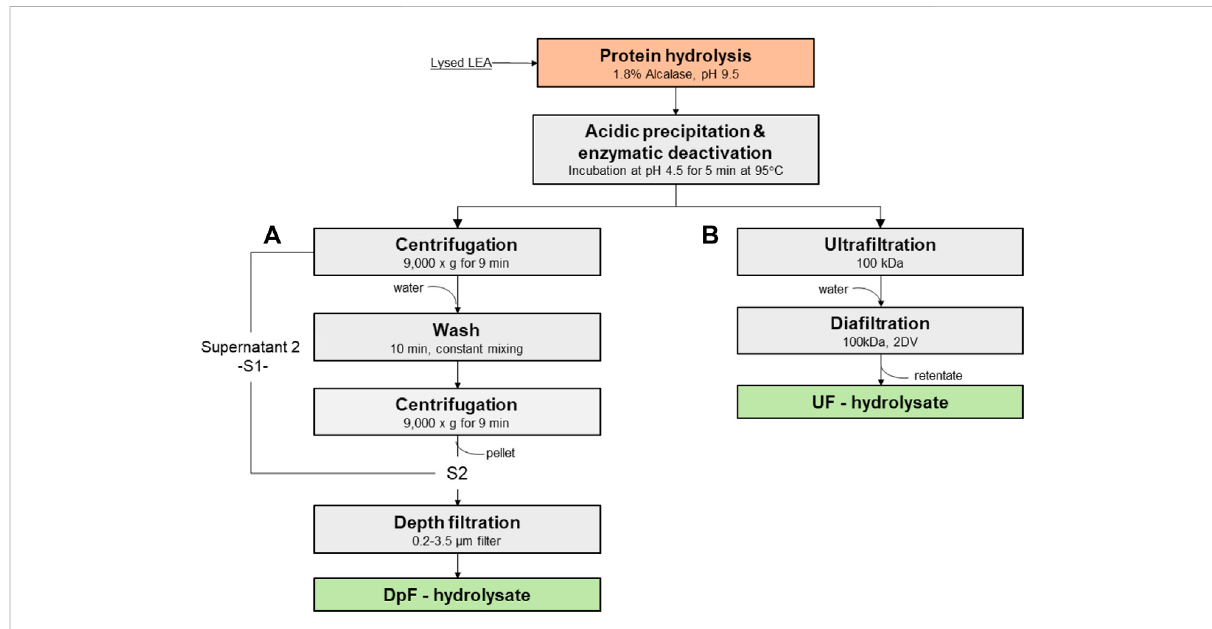
FIGURE 1 Processing routes to protein hydrolysates: (A) protein hydrolysates by centrifugation and depth fi ltration (DpF-hydrolysate) vs. (B) protein hydrolysates by ultra fi ltration and dia fi ltration